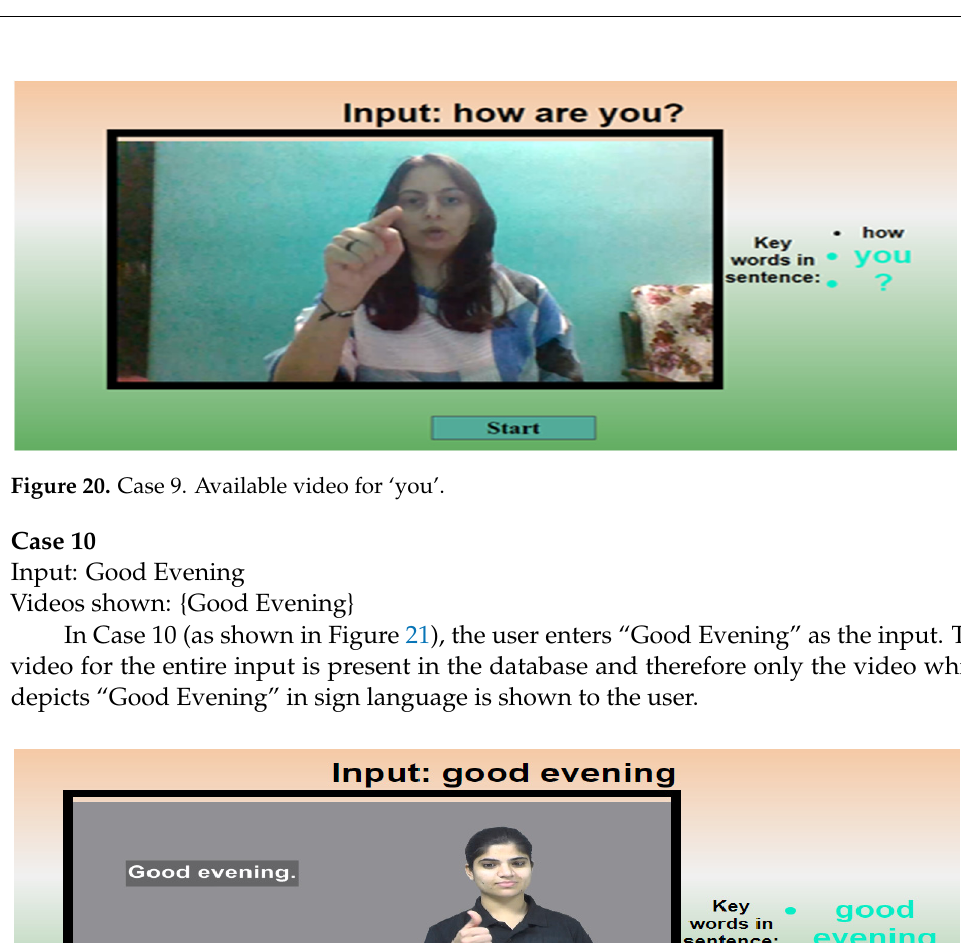
Figure 19. Case 9. Available video for ‘how’.